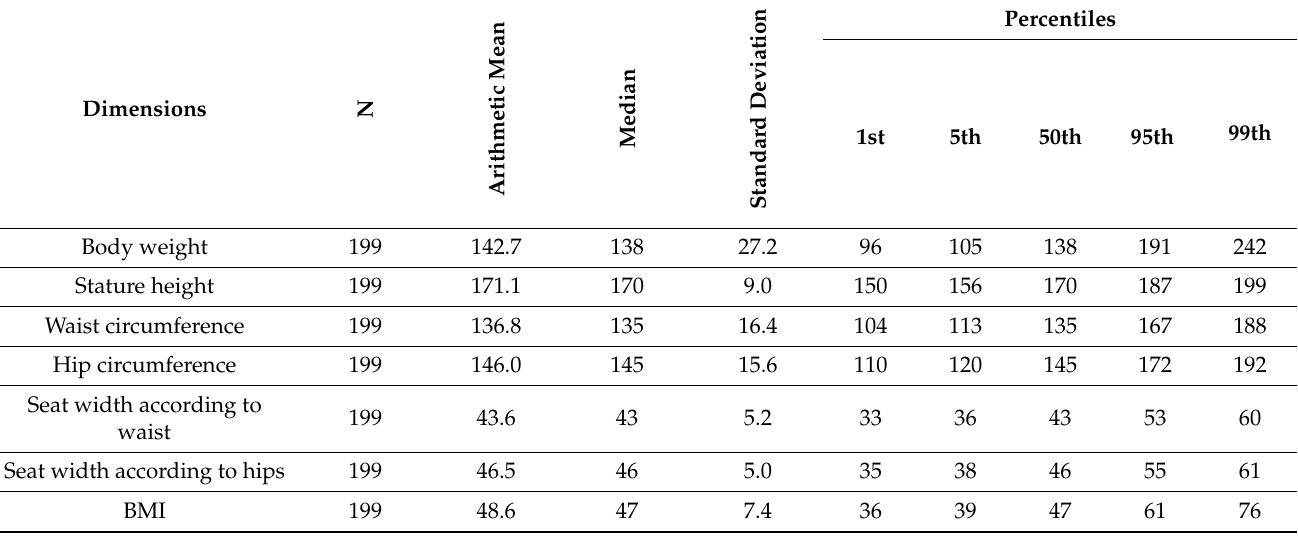
Table 2. Descriptive statistics of the bariatric population in 2020–2022.